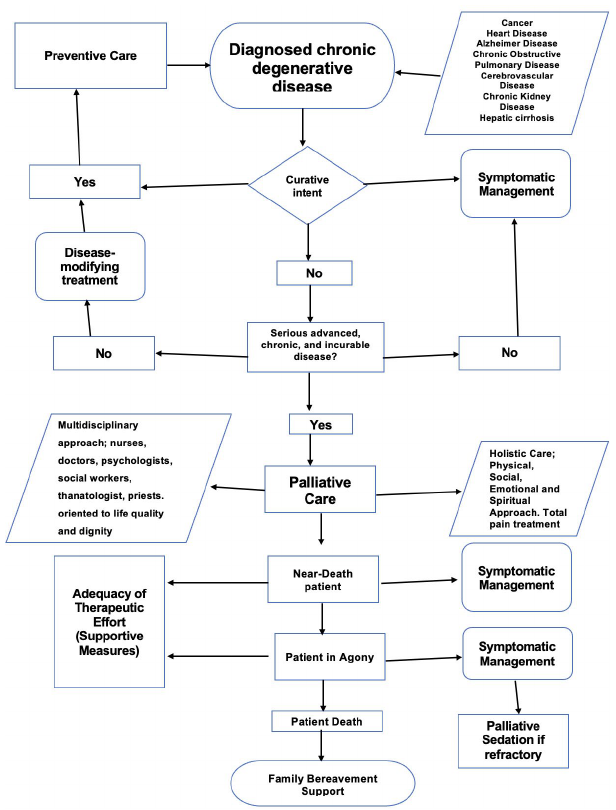
Figure 2 . Palliative Care